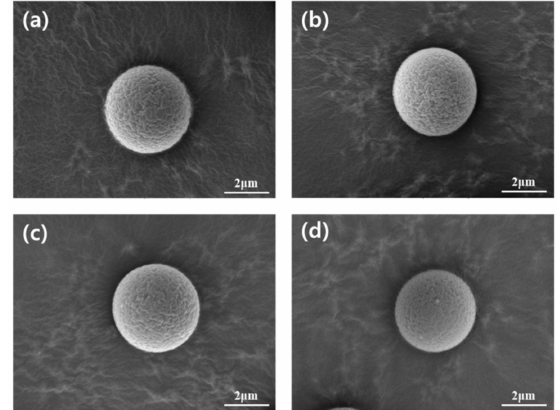
Figure 8. SEM image, according to polymer surface treatment: ( a ) polymer surface image after water washing, ( b ) surface image after cleaning and conditioning treatment, ( c ) surface image after activation treatment, and ( d ) surface image after acceleration treatment.